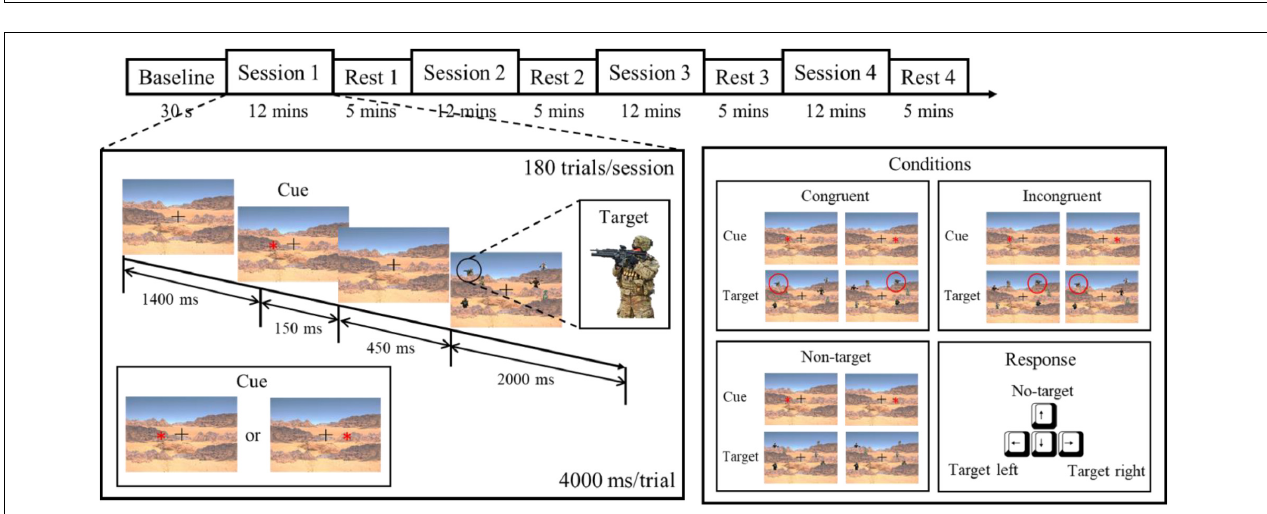
FIGURE 1 | Signal processing for parameters. The EEG signals were acquired through a 32-channel wireless EEG device and preprocessed for artifact removal. Then, the signals of the particular sites of interest were decomposed and normalized to yield five parameters.